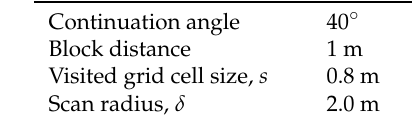
Table 4. Navigation module